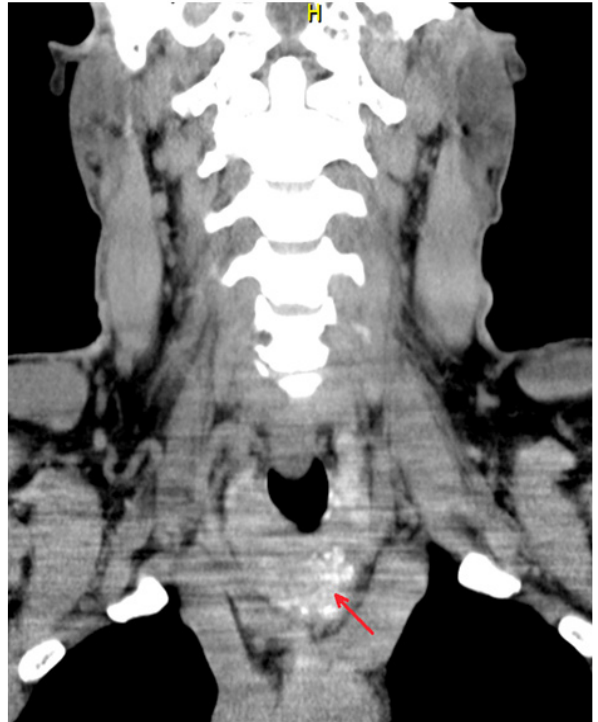
Fig. 2. CT scan: Enlarged isthmus of the thyroid gland 21–26 mm, which reaches the edge of the sternum with inhomoge- neous nodule 25×25×29 mm and